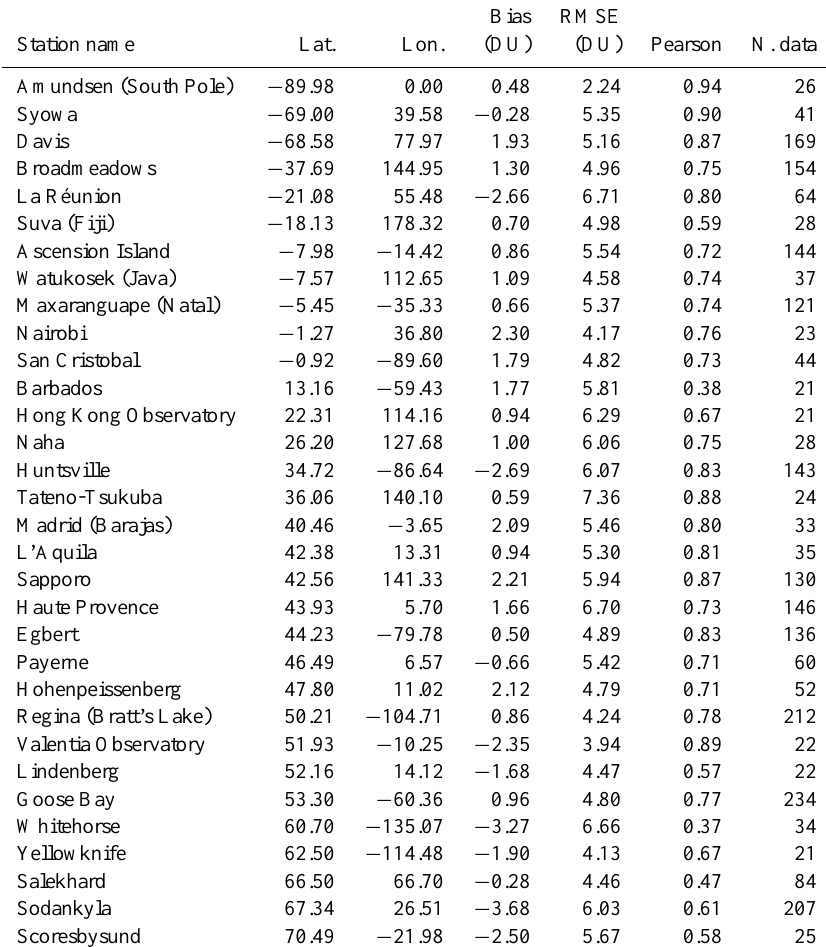
Table 4. Retrieval validation results divided by station, sorted by increasing latitude. Only stations with at least 20 measurements included in the D test set were considered.